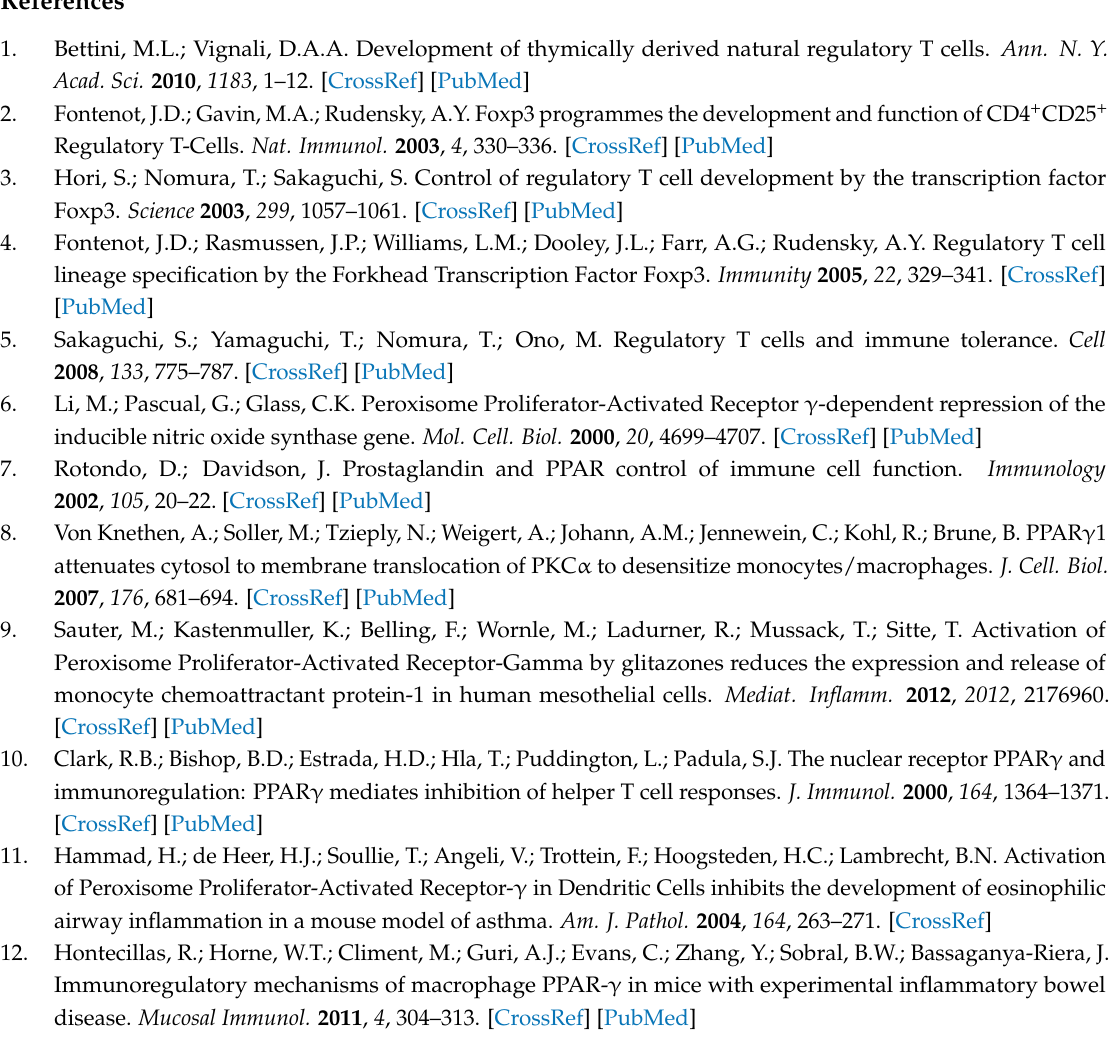
Table S1: Differentially expressed target genes of pathways related to immune cells in ciglitazone-treated nTreg cells from NOD mice, Table S2: Differentially expressed target genes of pathways related to immune cells in prostaglandin J 2 -treated nTreg cells from NOD mice, Table S3: Differentially expressed target genes of pathways related to immune cells in ciglitazone-treated nTreg cells from NOR mice, Table S4: Differentially expressed target genes of pathways related to immune cells in prostaglandin J 2 -treated nTreg cells from NOR mice. Author Contributions: All authors contributed equally in the design of the study, data collection, data analysis and preparation of the